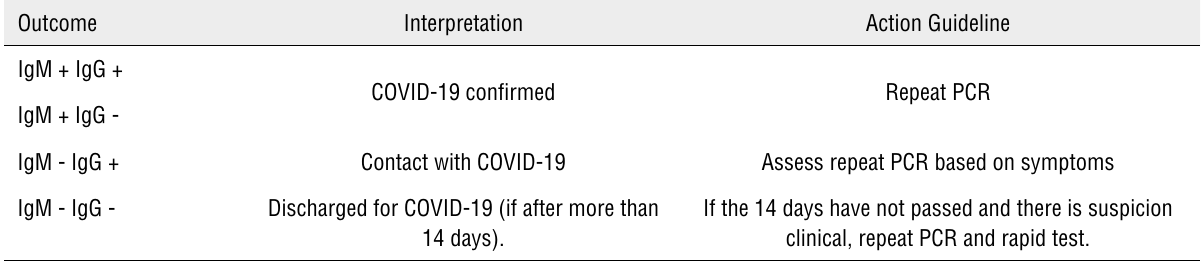
Table 1 - Usage of rapid tests in symptomatic professionals. April 2020.